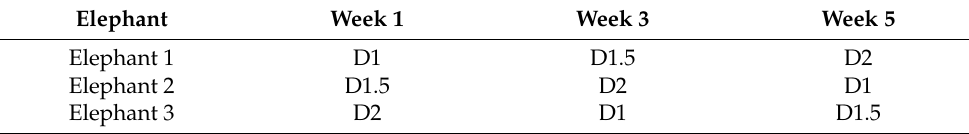
Table 1 . A crossover experimental design for 3 elephants Table 1. A crossover experimental design for 3 elephants.